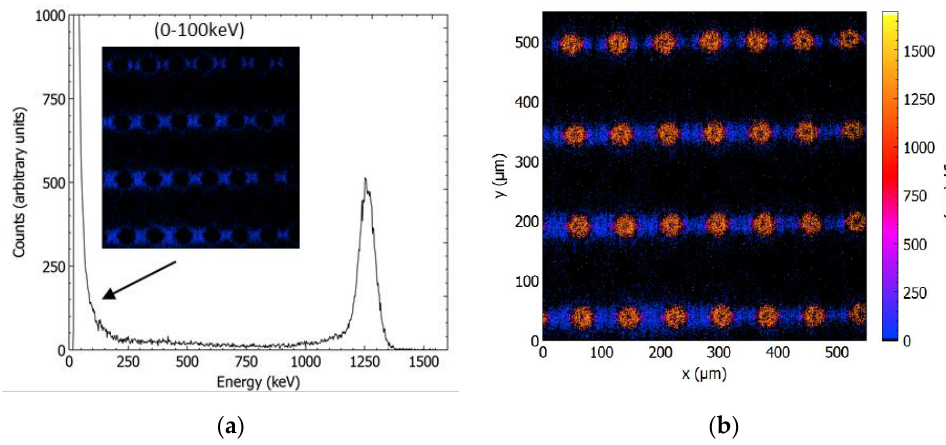
Figure 9. Trenched 3D Mushroom microdosimeter in response to a 5.5 MeV He 2+ ion microbeam ( a ) MCA spectrum and window energy map corresponding to low energy events and ( b ) full charge collection energy map of the even array at 10 V bias. The odd array was grounded [21].